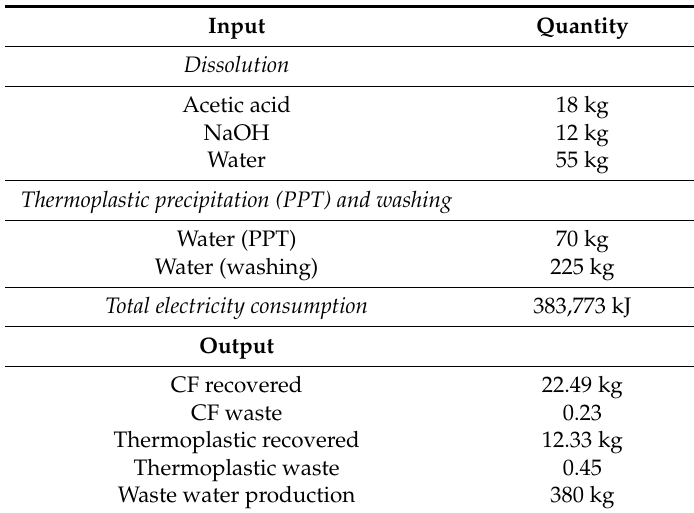
Table 4. Inventory analysis of the Connora recycling